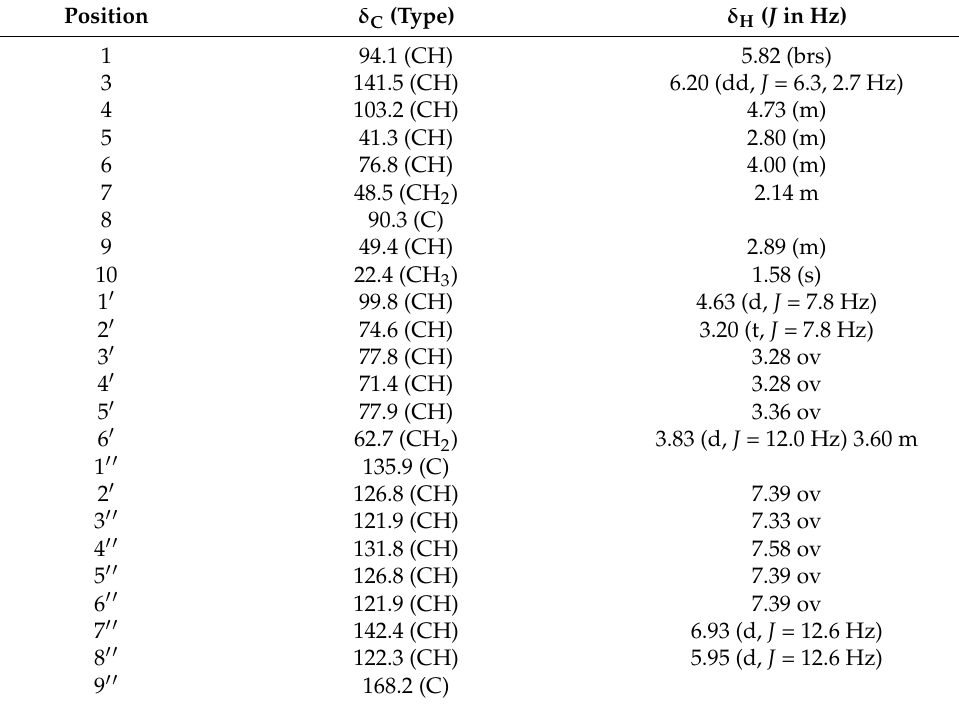
Table 3. Data 1 H-NMR and 13 C-NMR of compound 13 recorded in CD 3 OD. Position δ C